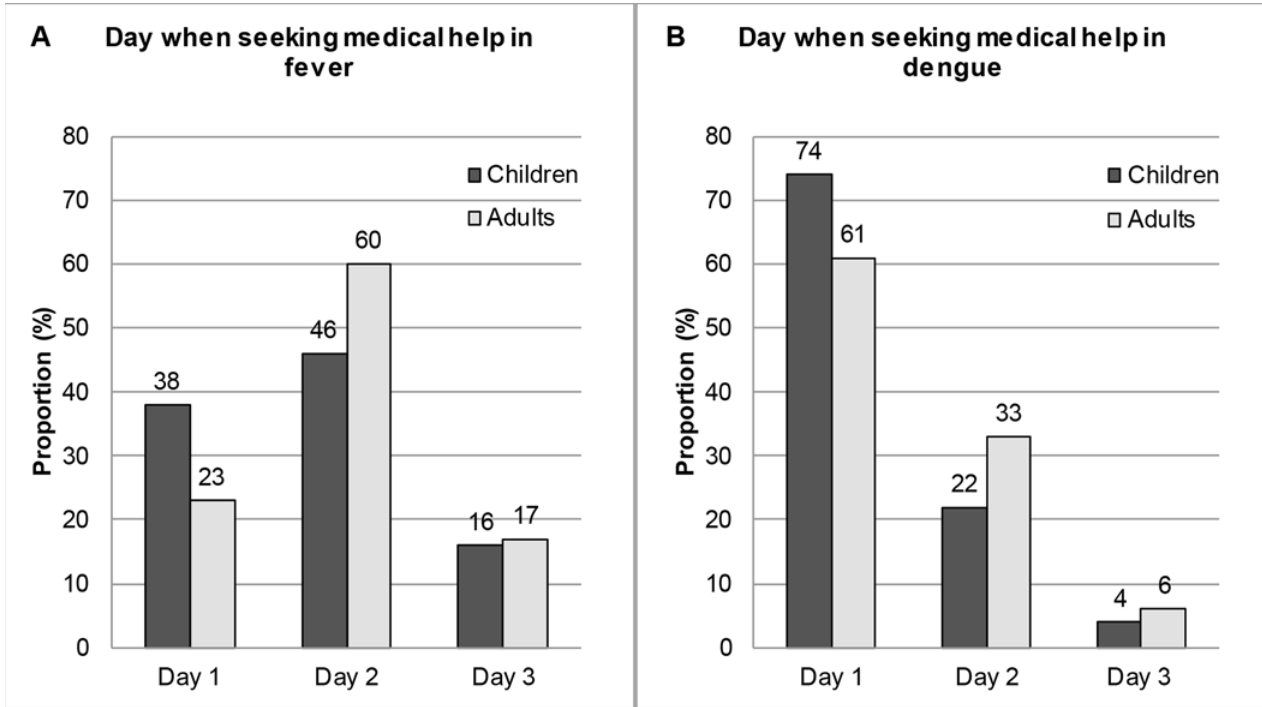
Fig 3. Day when seeking medical help in case of dengue and fever. Section A: children n = 51; adults n = 48. Section B: children n = 51; adults n = 51.